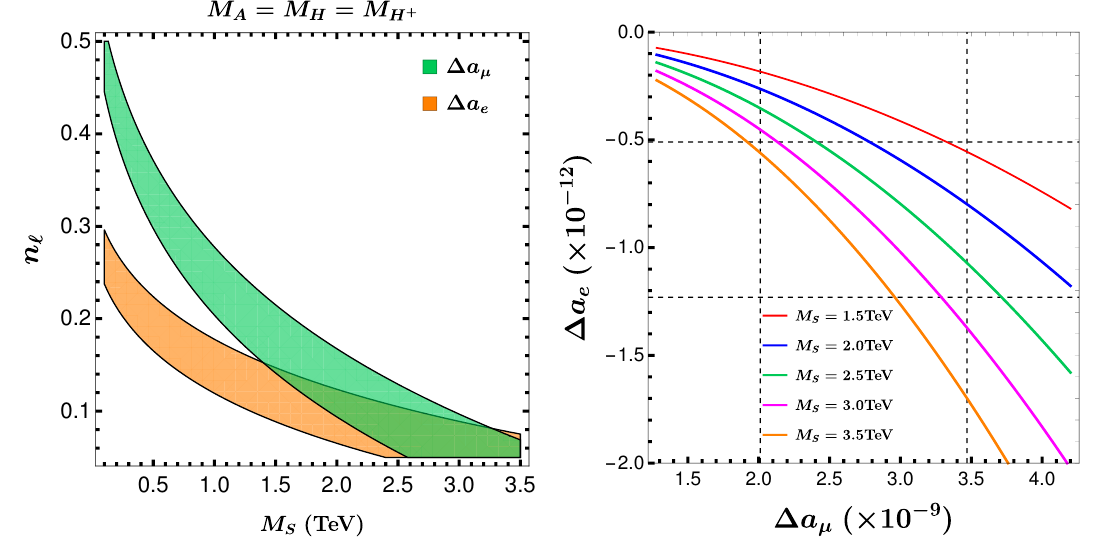
Figure 2 . Left: allowed parameter region in the ( M S , n ‘ ) plane needed to realize a simultaneous explanation of ∆ a e,µ at 1 σ level, in the degenerate limit of Higgs mass spectrum. Right: correlation between ∆ a µ and ∆ a e for different choices of the degenerate Higgs mass M S . The black dashed lines represent the 1 σ intervals of ∆ a e,µ , given by eqs. (1.1) and